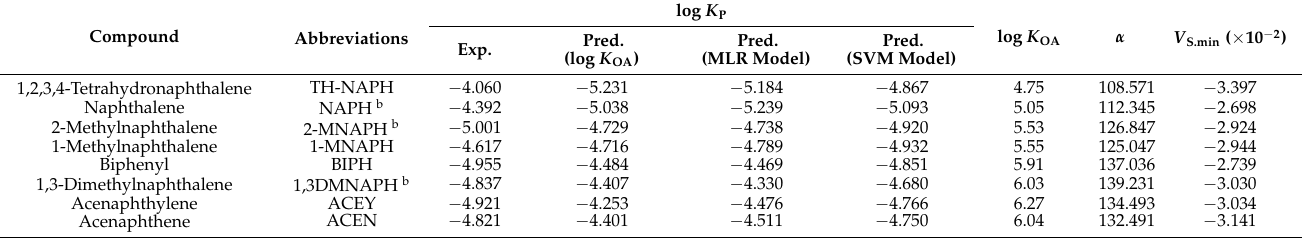
Table 1. Experimental and predicted log K P values, log K OA values, and molecular structure descrip- tors employed in the QSAR model for 50 PAHs and their oxygen/nitrogen derivatives a